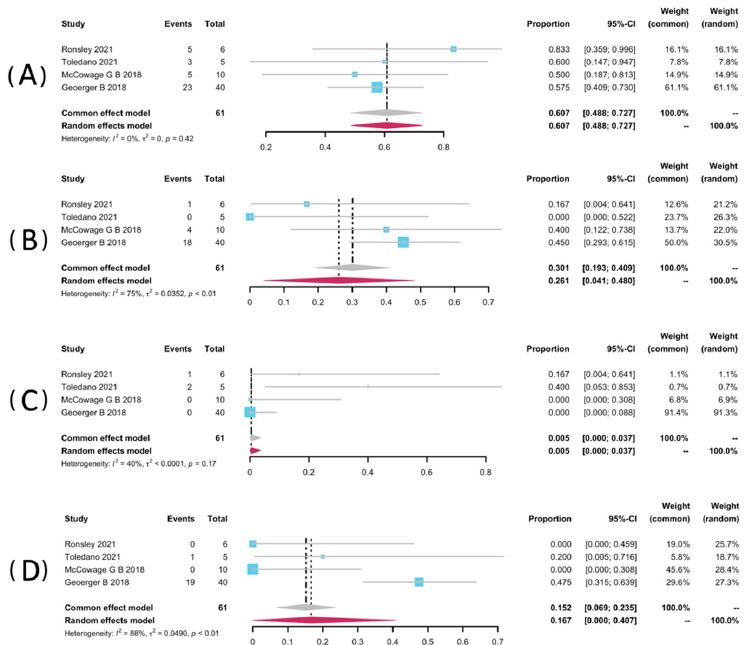
Figure 5. Forest plots for the adverse events paronychia ( A ), rash ( B ), mouth ulcer ( C ), and diarrhea ( D ) in patients receiving ( D ) in patients receiving trametinib.